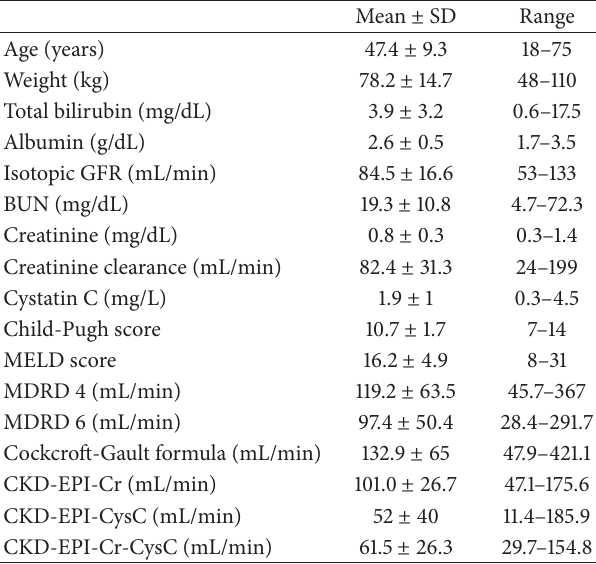
Table 2: Baseline characteristics of the enrolled patients. Table 3: Demographic and clinical data of the enrolled patients.